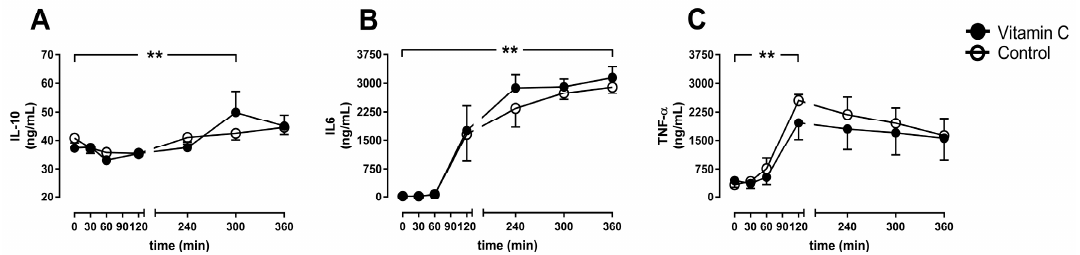
Figure 6. Interleukin 10 (IL10; A), IL6 (B), and Tumor necrosis factor-alpha (TNF- α ; C). ** p < 0.01 effect of time for both groups.